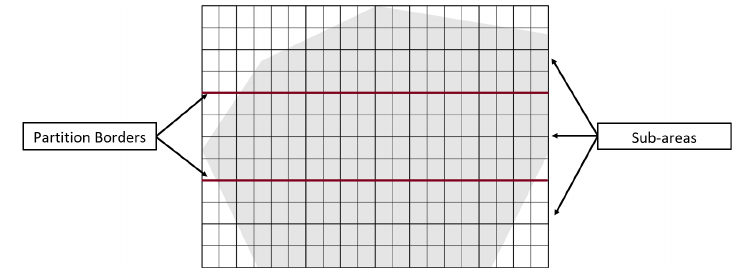
Figure 16. Area partitioned using PPS-W